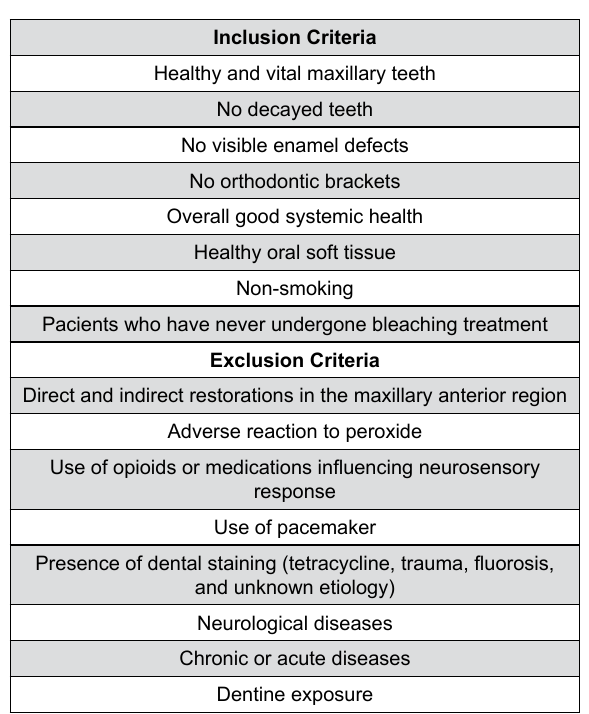
Figure 1- Inclusion and exclusion criteria for selection of patients